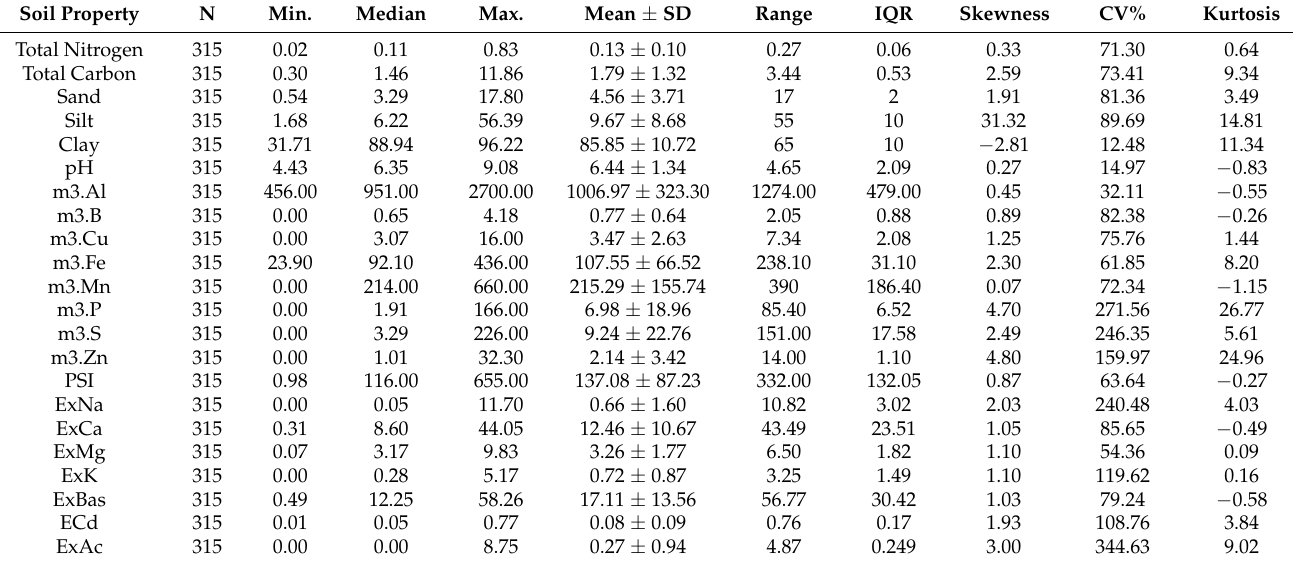
Table 1. Summary statistics for laboratory soil properties measured as potential indicators of soil health. Soil